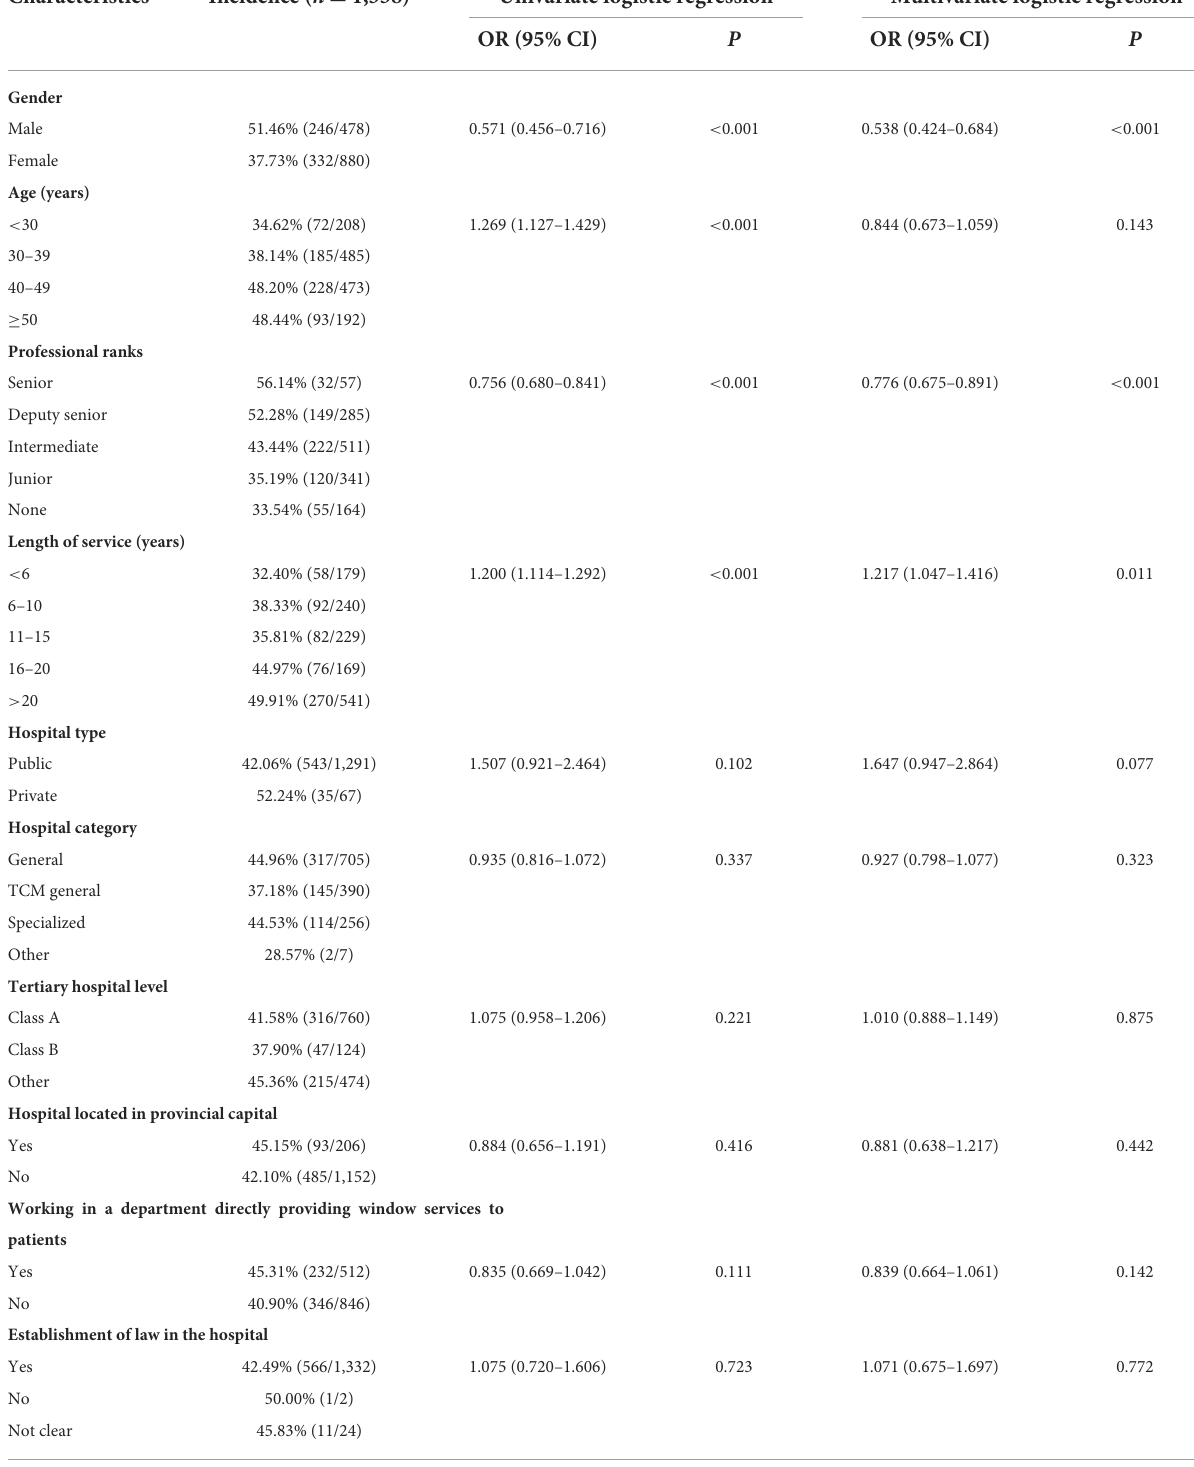
TABLE 3 Multivariate logistic regression analyses of potential risk variables for hospital administrators encountered medical disputes at work in the training group. Characteristics Incidence ( n = 1,358) Univariate logistic regression Multivariate logistic